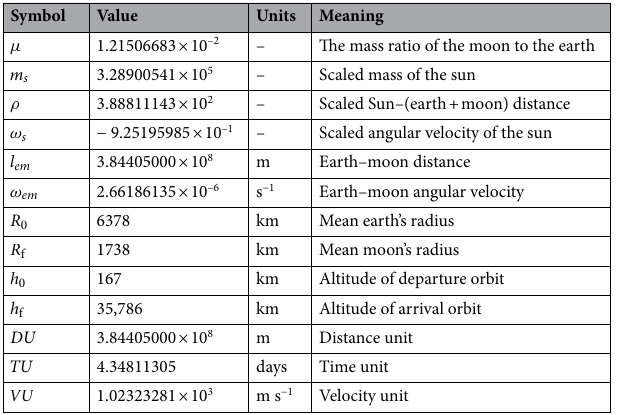
Table 1. Earth-moon space constants 14